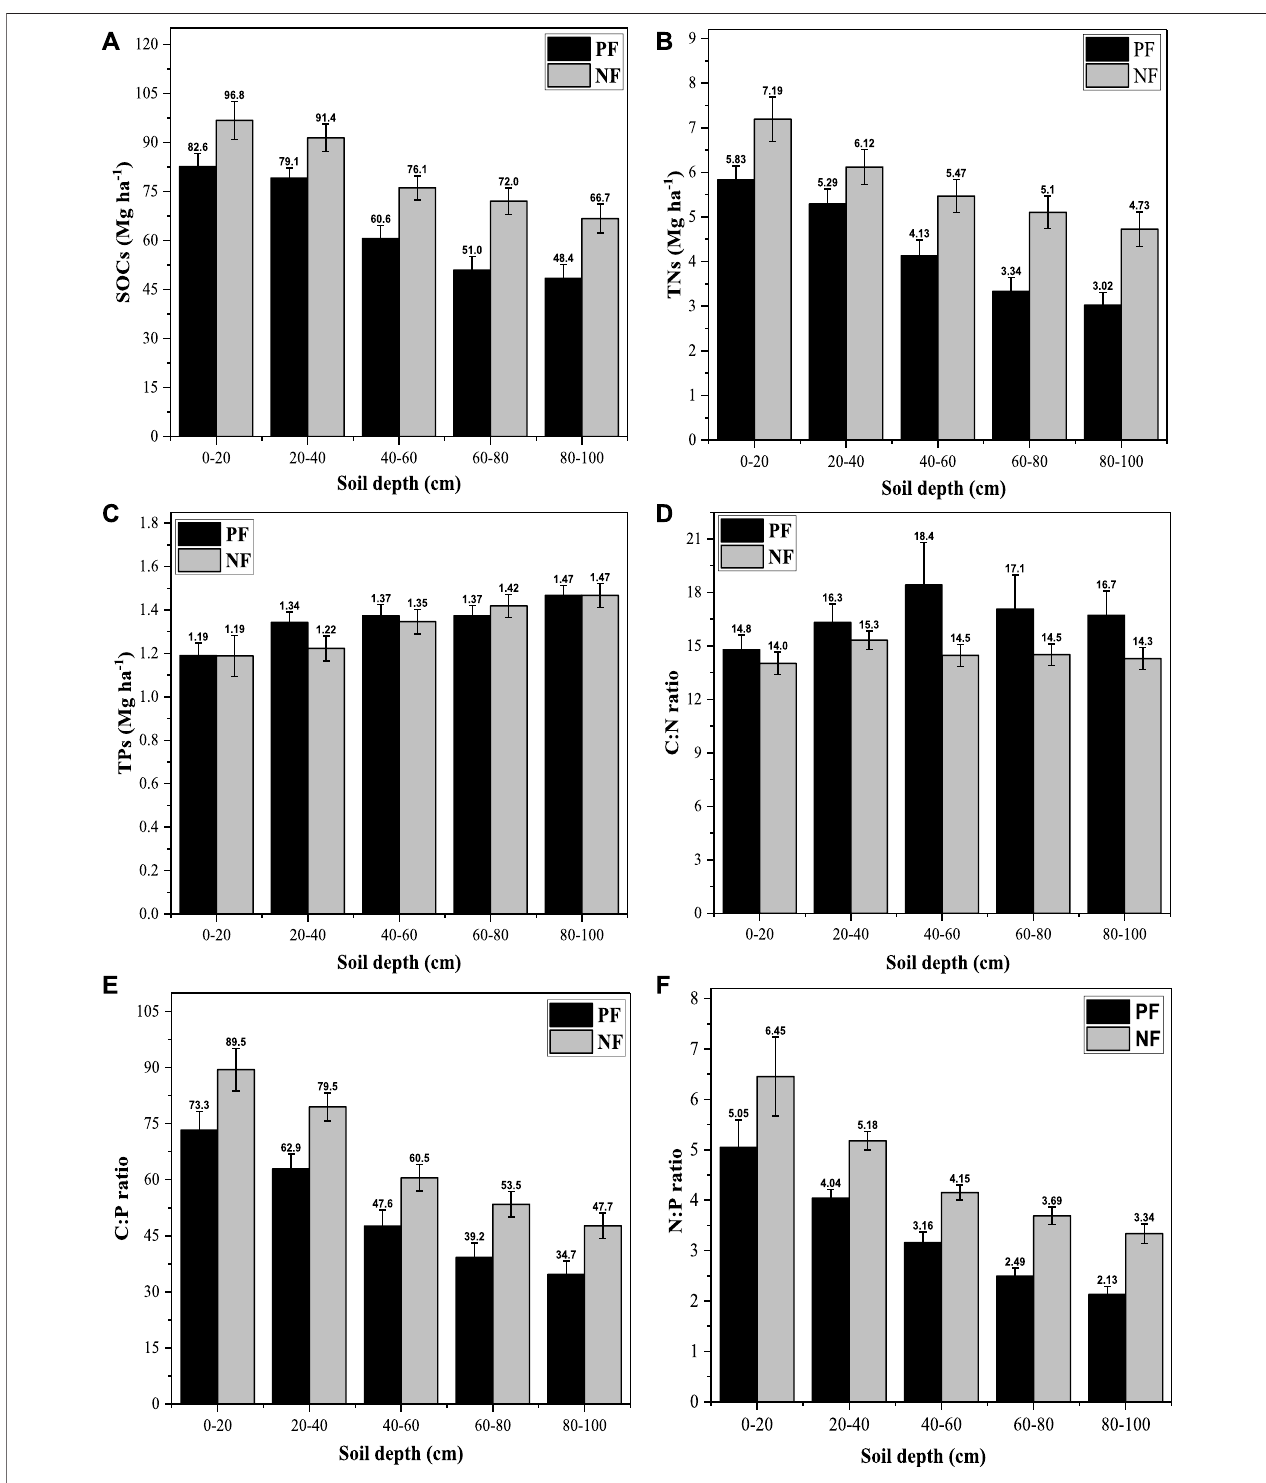
FIGURE 3 | The SOC, TN, and TP stocks and stoichiometry under different soil depths for PF and NF. The error bars indicate standard error. The SOCs, TNs, and TPs indicate soil organic carbon, total nitrogen, and total phosphorus stocks respectively.